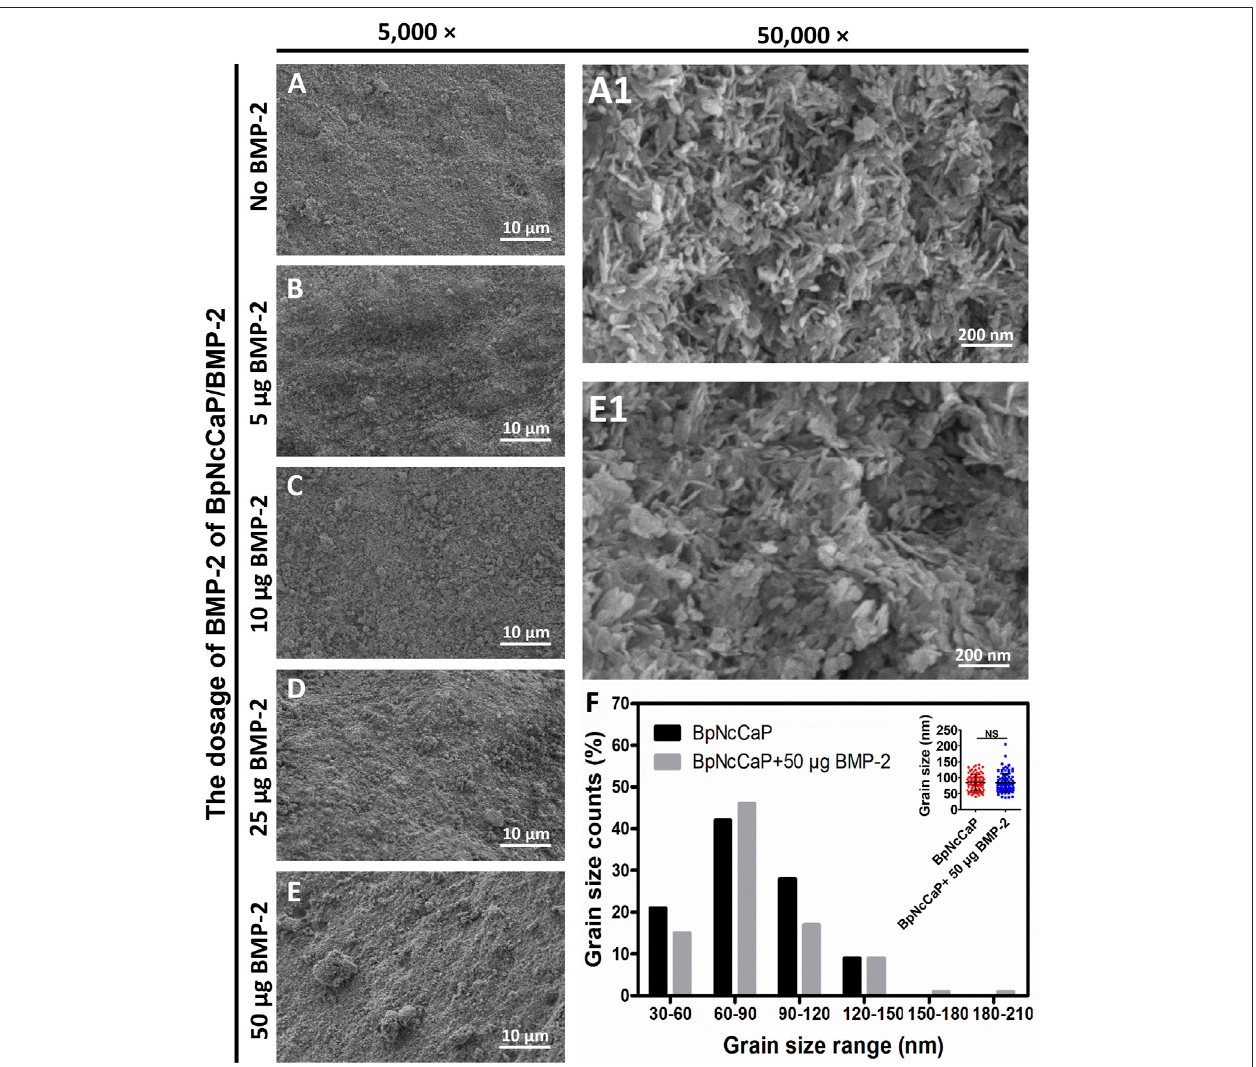
FIGURE 2 | Scanning electron microscopy (SEM) observations of surface characteristic and morphology of BpNcCaP without or with different amounts (5/10/25/ 50 μ g) of BMP-2. Representative SEM images of BpNcCaP without (A) or with different amounts (5/10/25/50 μ g) of BMP-2 (B – E) in a lower magni fi cation (×5,000). Bar = 10 μ m. Higher-magni fi cation (50,000×) SEM images of BpNcCaP (A1) and BpNcCaP+50 μ g BMP-2 (E1) . Bar = 200 nm. (F) Graph depicting the grain size distribution of BpNcCaP and BpNcCaP+50 μ g BMP-2.